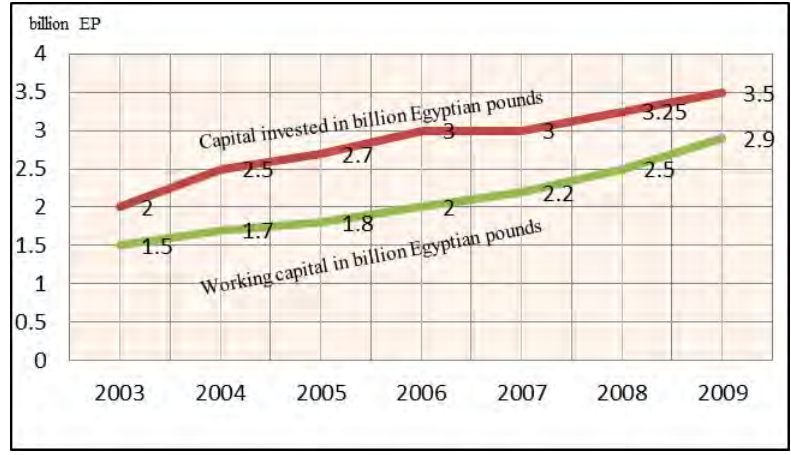
Figure 2. Development of Invested and working Capitalduring the Period 2003 – 2009